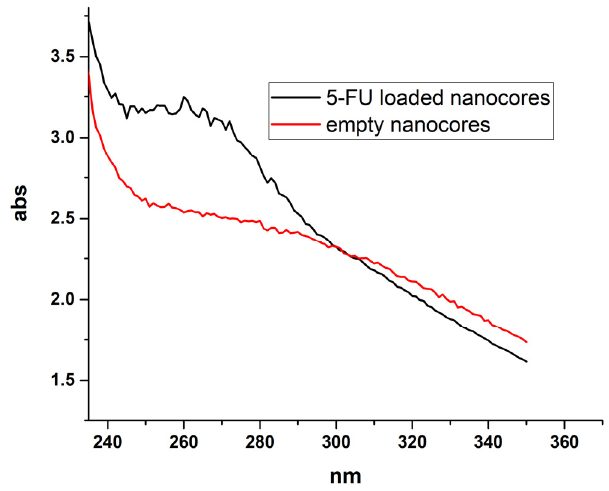
Figure 2. The comparison of UV–Vis spectra of empty and 5-FU loaded nanocarriers provided as evidence of successful encapsulation.